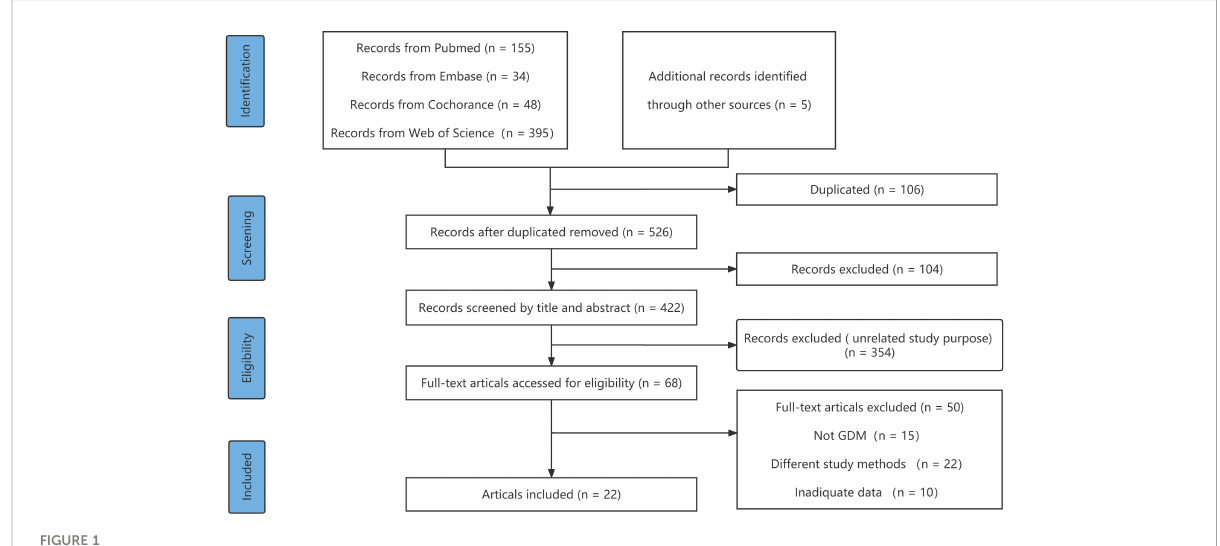
FIGURE 1 The PRISMA fl ow diagram of study identi fi